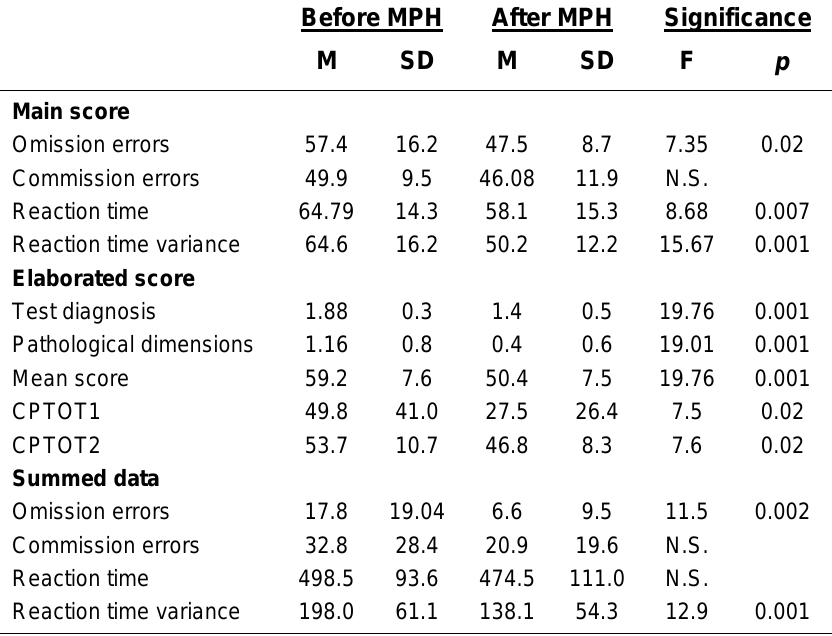
Mean Scores and Standard Deviations of TOVA Before and After Methylphenidate (MPH) Before MPH After MPH